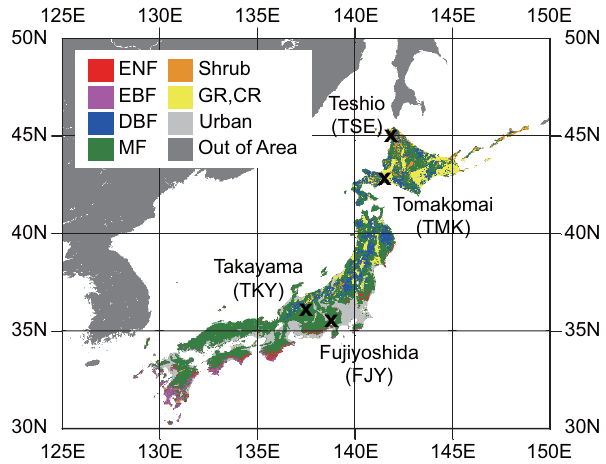
Fig. 1. Land cover of the study area based on MODIS land cover data (MOD12Q1; Friedl et al., 2002) in year 2001 with the eddy flux observation sites used in this study. Xs show the locations of the eddy flux observation stations used in the study. Abbreviations of land cover classes: Evergreen Needleleaf Forest (ENF), Ever- green Broadleaf Forest (EBF), Deciduous Needleleaf Forest (DNF), Deciduous Broadleaf Forest (DBF), Mixed Forest (MF), Grass- land (GR), and Cropland